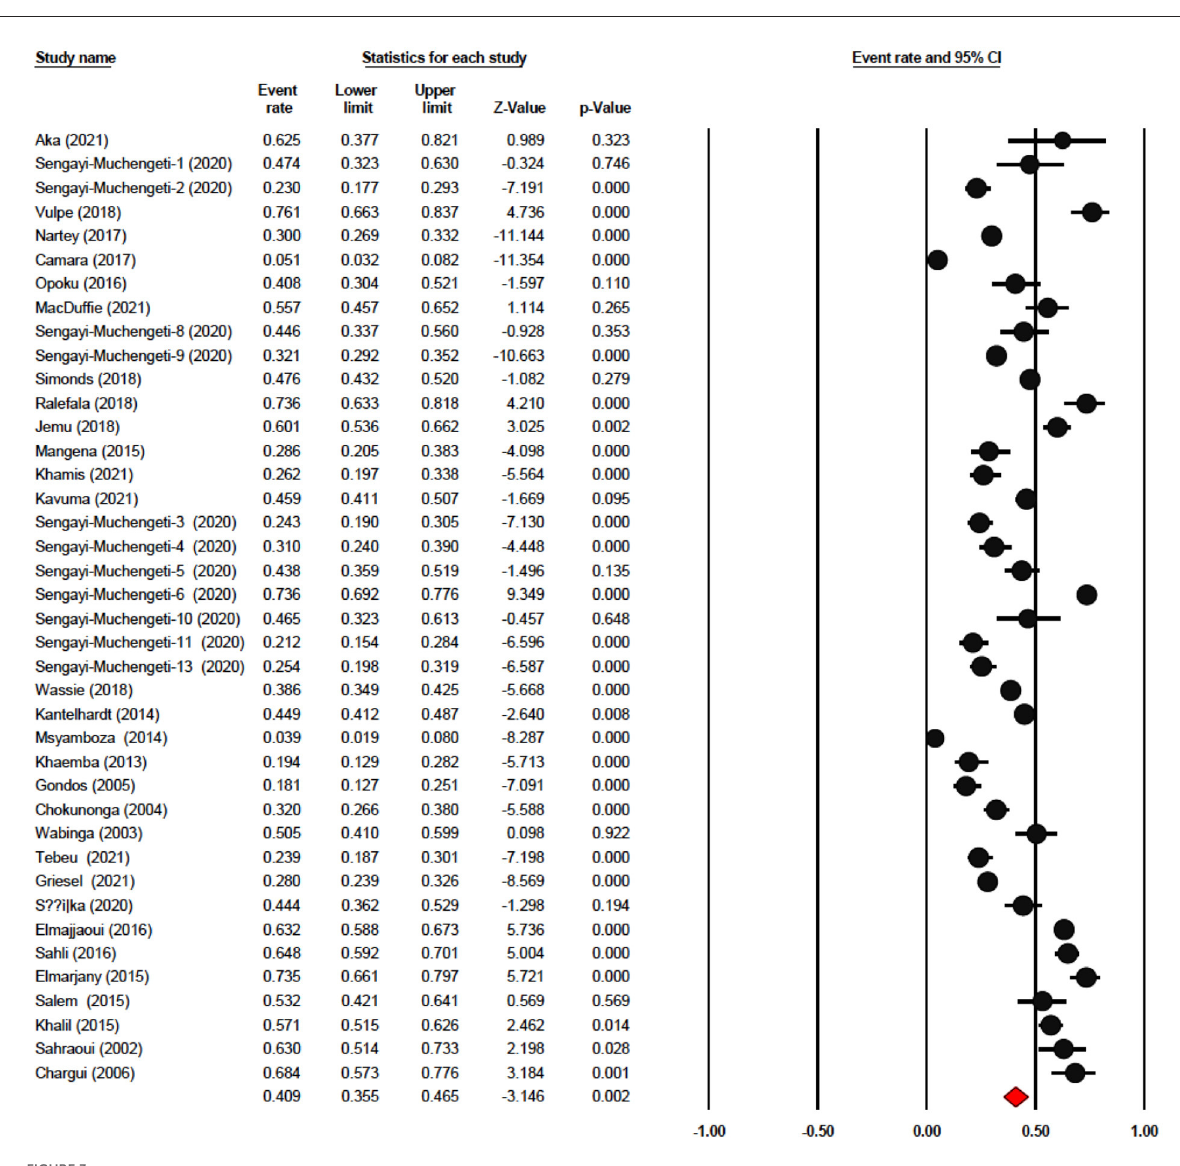
FIGURE3 Forest plot showing the 5-year